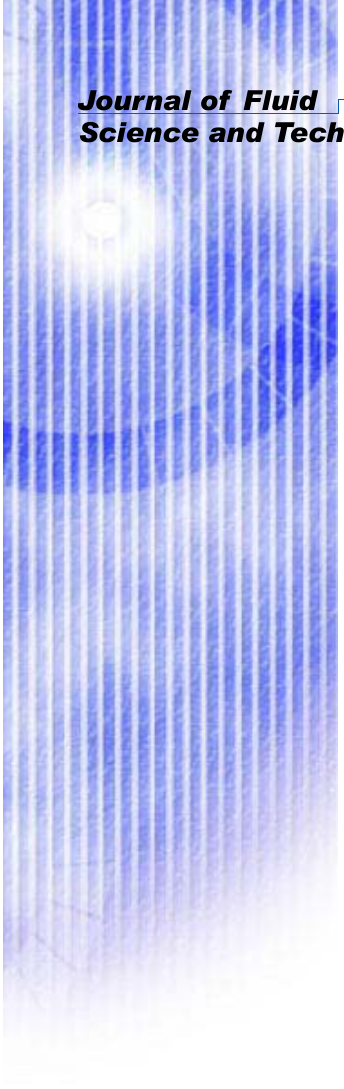
) and the vorticity thickness ( δ ) u , and the ratio of δ / θ is around u along stream-wise distance is one of u (even for δ and θ u